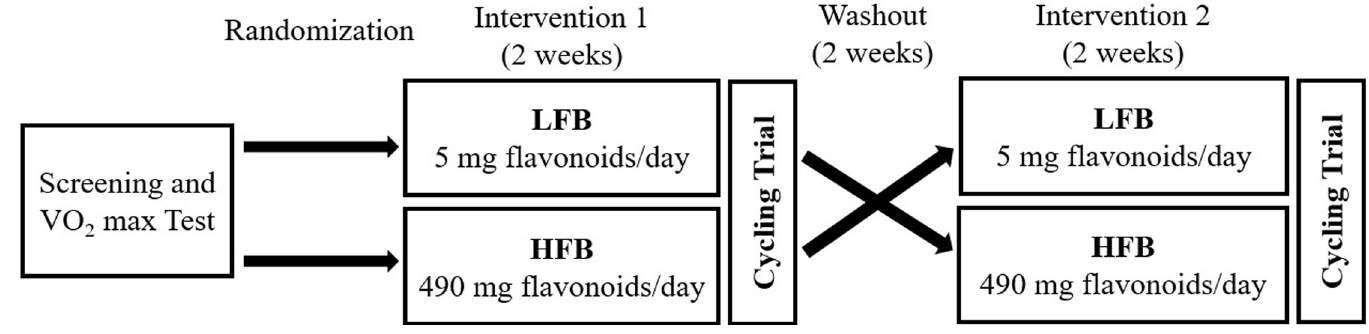
Fig 2. Schematic overview of the crossover study